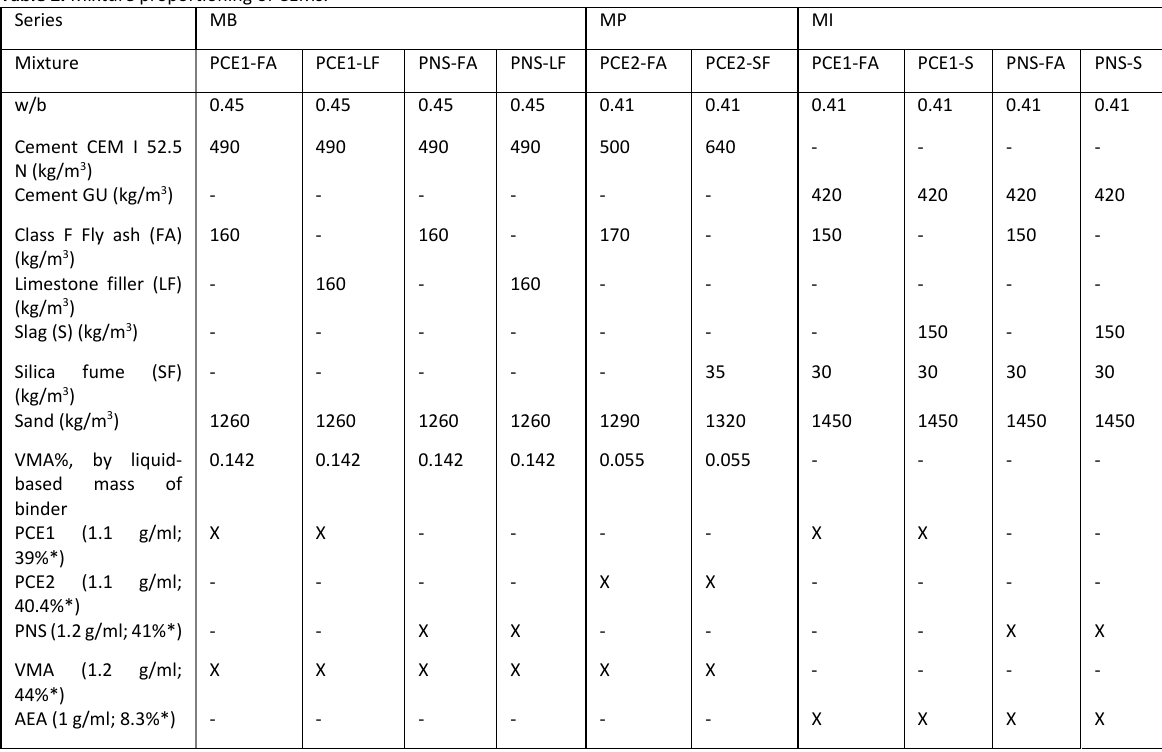
Table 2. Mixture proportioning of